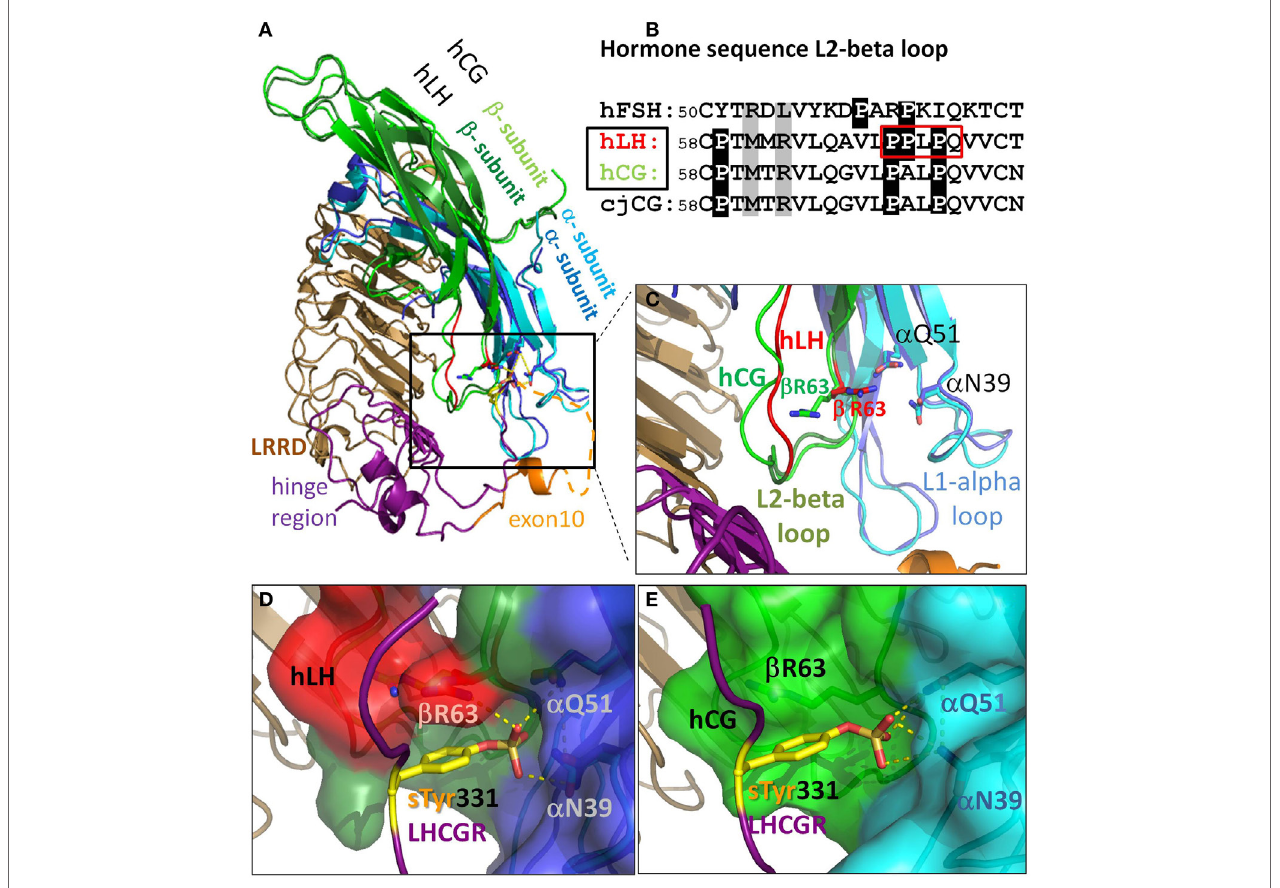
FigUre 3 | There are differences in the l2-beta loop for hlh and hcg . This gives rise to tighter binding for hLH than for hCG at sTyr331, the second binding site at LHCGR. (a) Homology model details of superimposed hormones hLH and hCG extracellularly bound to LRRD and hinge region of LHCGR based on the crystal structure of FSH/FSHR [4AY9, Ref. (9)]. (B) Sequence differences in L2-beta loop of these glycoprotein hormones (cjCG: New world monkey Callithrix jacchus ). Gray: positions representing interacting elements of the sTyr moiety of the LHCGR hinge region. White on black background: differences in prolines between FSH and hLH, hCG, and even between hLH (red boxed) and hCG. (c) hLH was modeled based on the hCG structure (PDB: 1HRP, light green). Close up view: the L1-alpha loop is similar for hLH (dark blue) and hCG (cyan). The differing conformations of the L2-beta loop for hLH is based on a fragment in the crystal structure of Insulysin (3TUV) with identical sequence PPLPQ. The resulting backbone conformation of hLH (red) clearly differs from that in hCG structure (light green). The additional proline in hLH (see red box in B) restricts the conformational degree of freedom of β R63 (red) located in the N-terminal flank of the L2-beta loop. (D) Detailed view for hLH. The resulting binding cavity for sTyr331 formed by the L1-alpha loop (dark blue surface) and L2-beta loop (red surface) is more surrounded in hLH, and is flanked by the β R63 (red) and thus provides an additional H-bond donor for the interaction with the sTyr331 (yellow) of LHCGR compared to (e) detailed view for hCG (light green), where β R63 does not interact with sTyr331 and the binding pocket is much